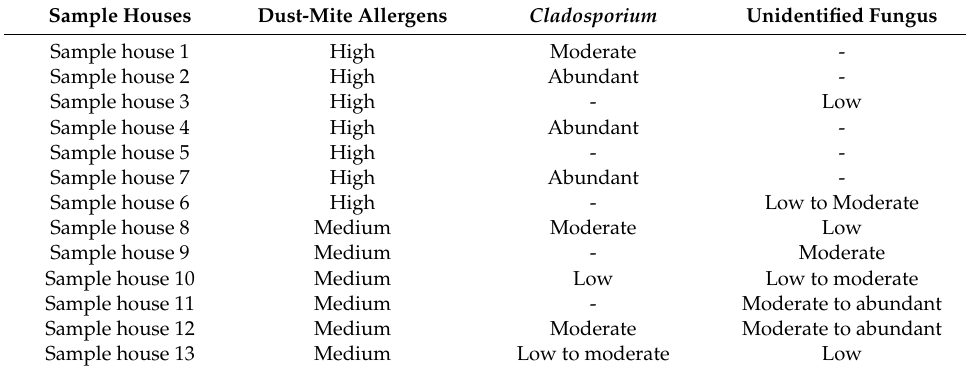
Table 6. Sample houses with high or medium levels of dust-mite allergens and mould in test results. Sample